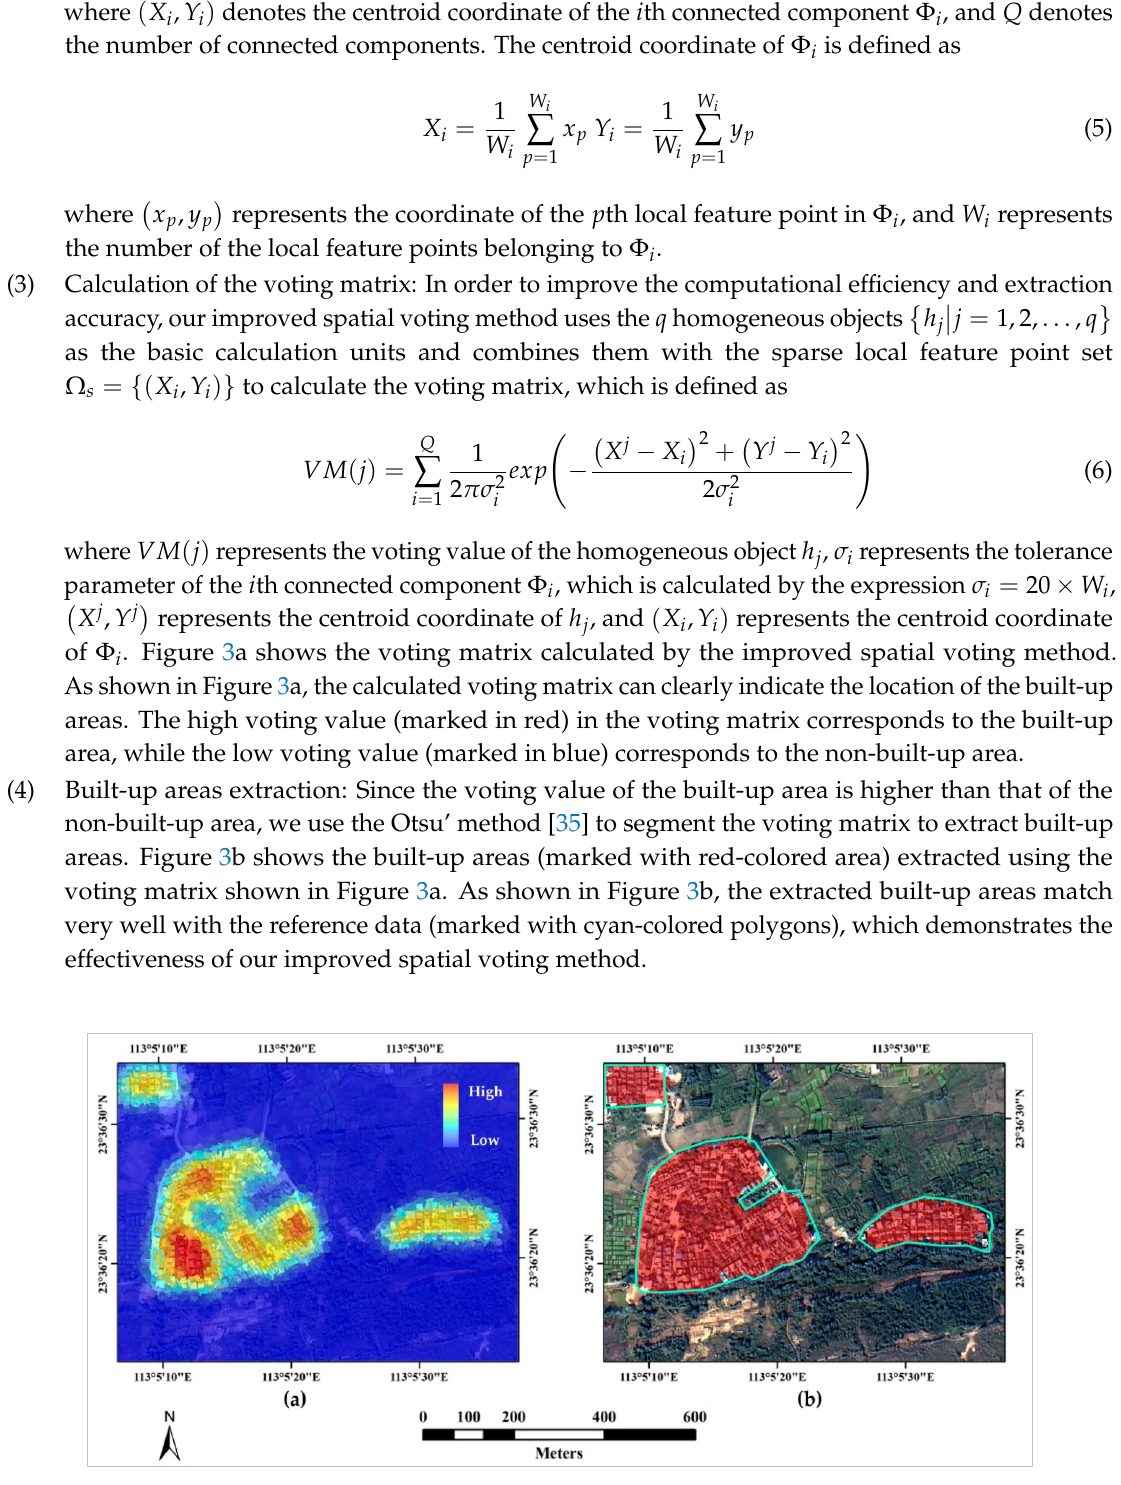
Figure 3. Improved spatial voting results. ( a ) The calculated voting matrix; ( b ) The extracted built-up areas (marked with red-colored area) and their corresponding reference data (marked with cyan-colored polygons).